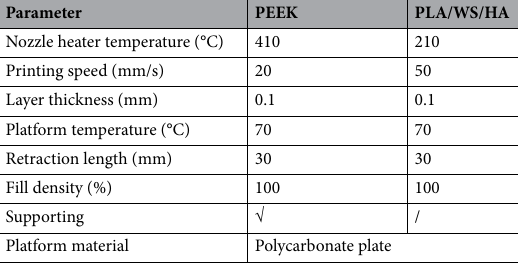
Table 2. Processing parameters of FFF for manufacturing PEEK-PLA/WS/HA